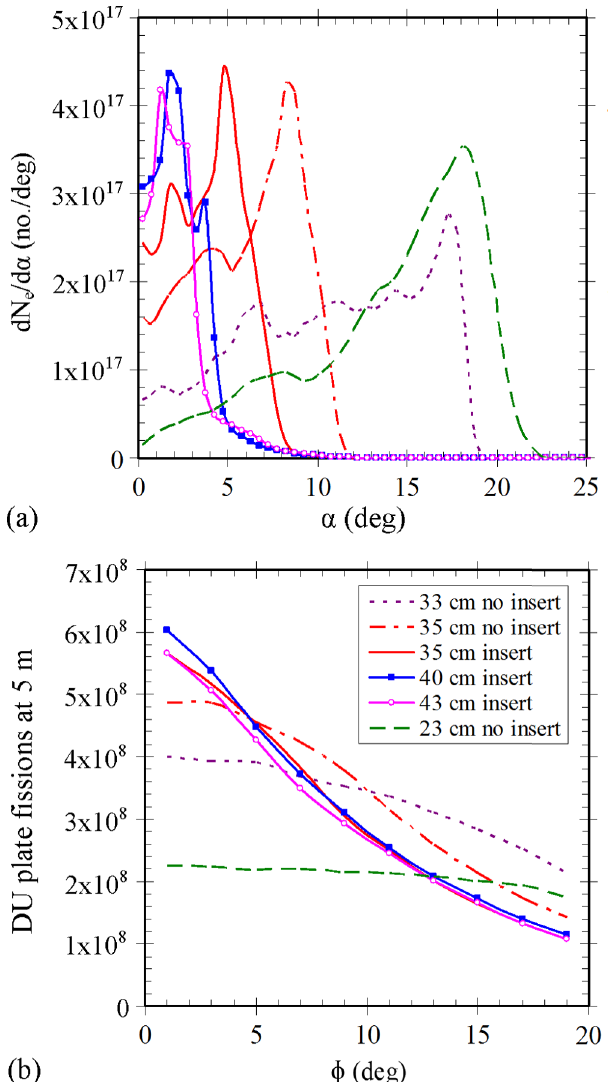
FIG. 12. (a) Distributions of time-integrated electron incidence angles on the converter for different AK gaps as computed by LSP. Here, α is the momentum-space angle measured from the axis of symmetry. Curve labels are as in Fig. 12(b). (b) Variation of fission yield in the DU plate 5 m from the converter vs the angle the plate is displaced from the axis of symmetry. Here, Φ is the configuration-space angle measured from the axis of sym- metry to a normal through the center of the